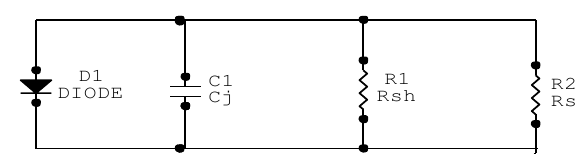
Figure 3. The block diagram of the system setup.